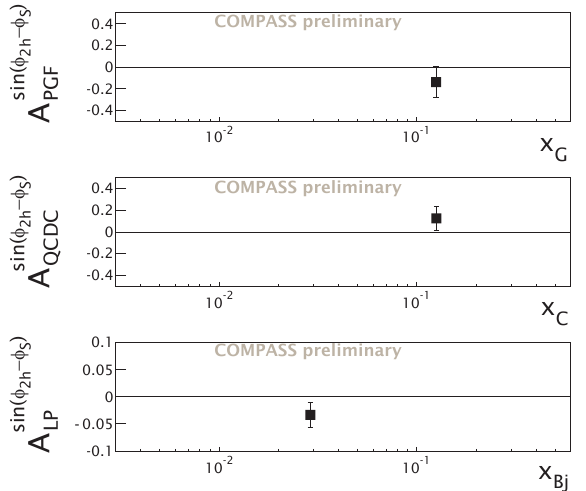
Figure 10. COMPASS Sivers asymmetry for gluons (top) to- gether with the measured asymmetries for the QCD Compton process (middle) and the leading order γ ∗ q → q process (bot- tom).